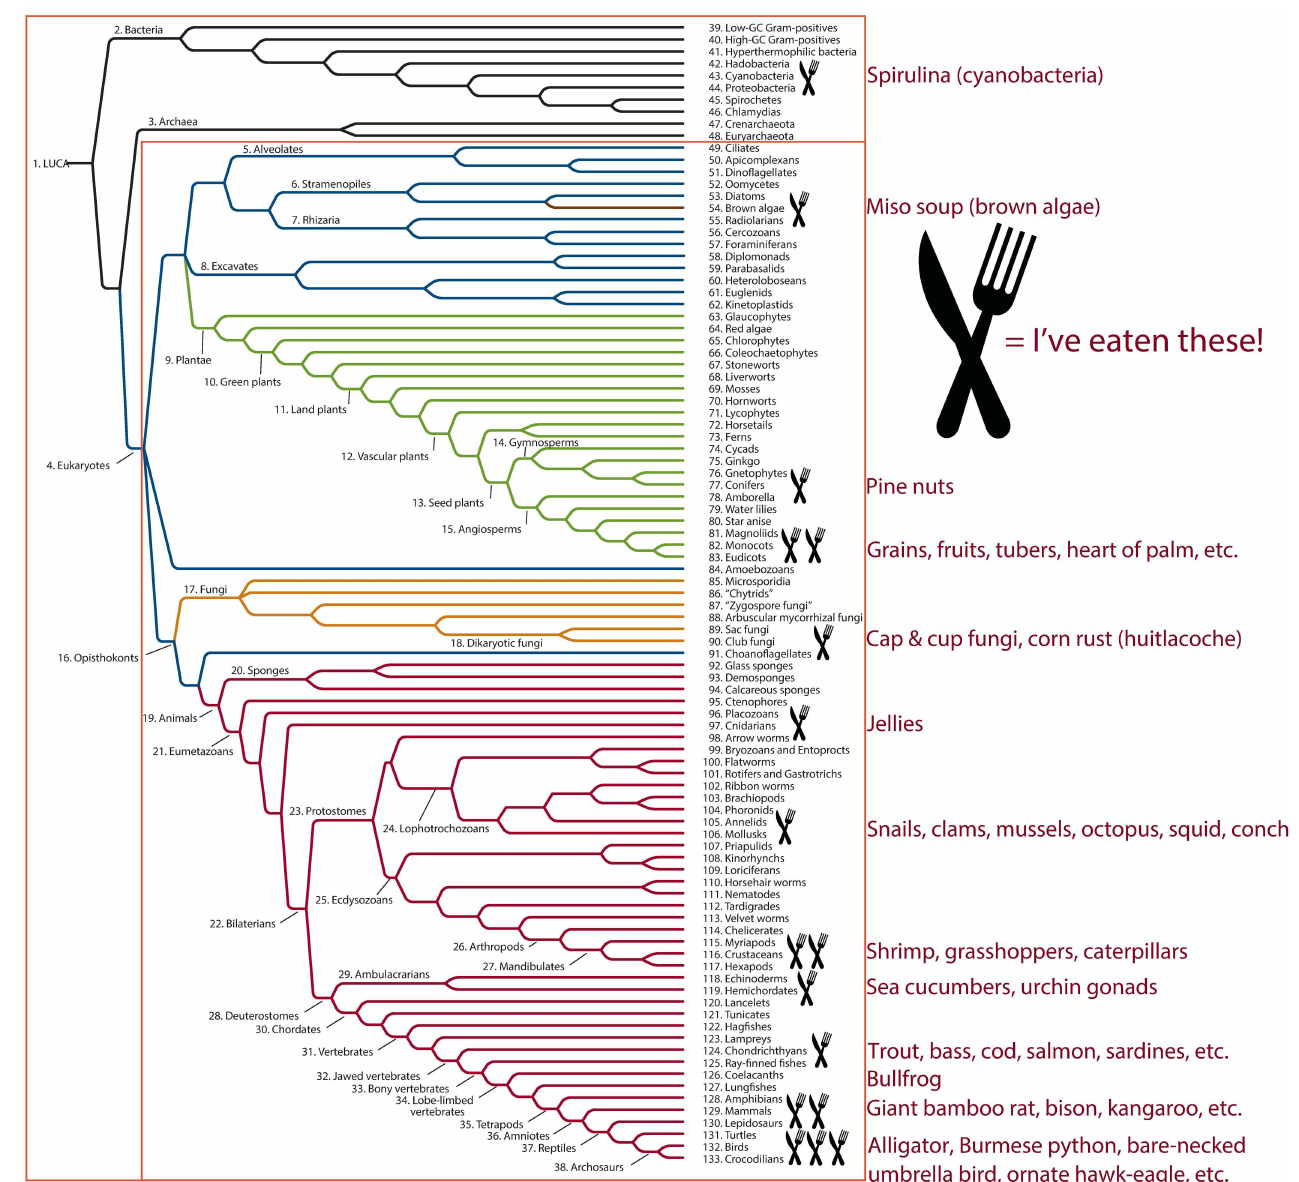
Fig 5. To summarize the tree of life module in our introductory evolution and biodiversity course, Greene expands his Lifetime Phylogenetic Dietary Diversity from Eukaryotes (inner red box) to LUCA (outer red box) by consuming a Spirulina capsule in front of the class (phylogeny used with permission from Sinauer Associates, Hillis et al.